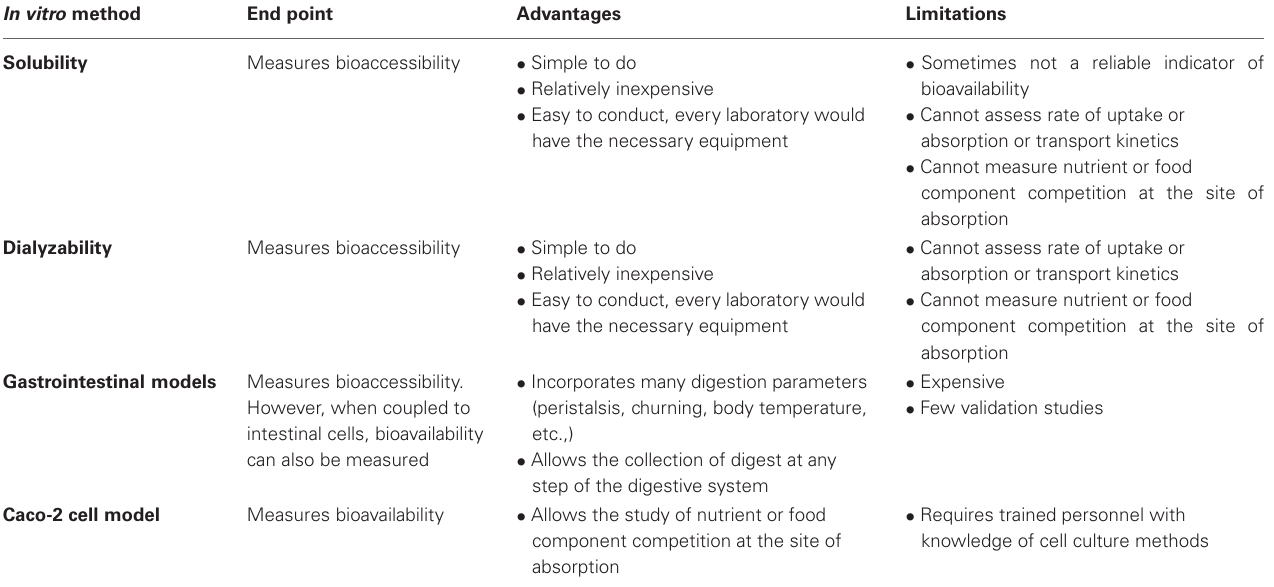
Table 1 | In vitro screening methods. In vitro